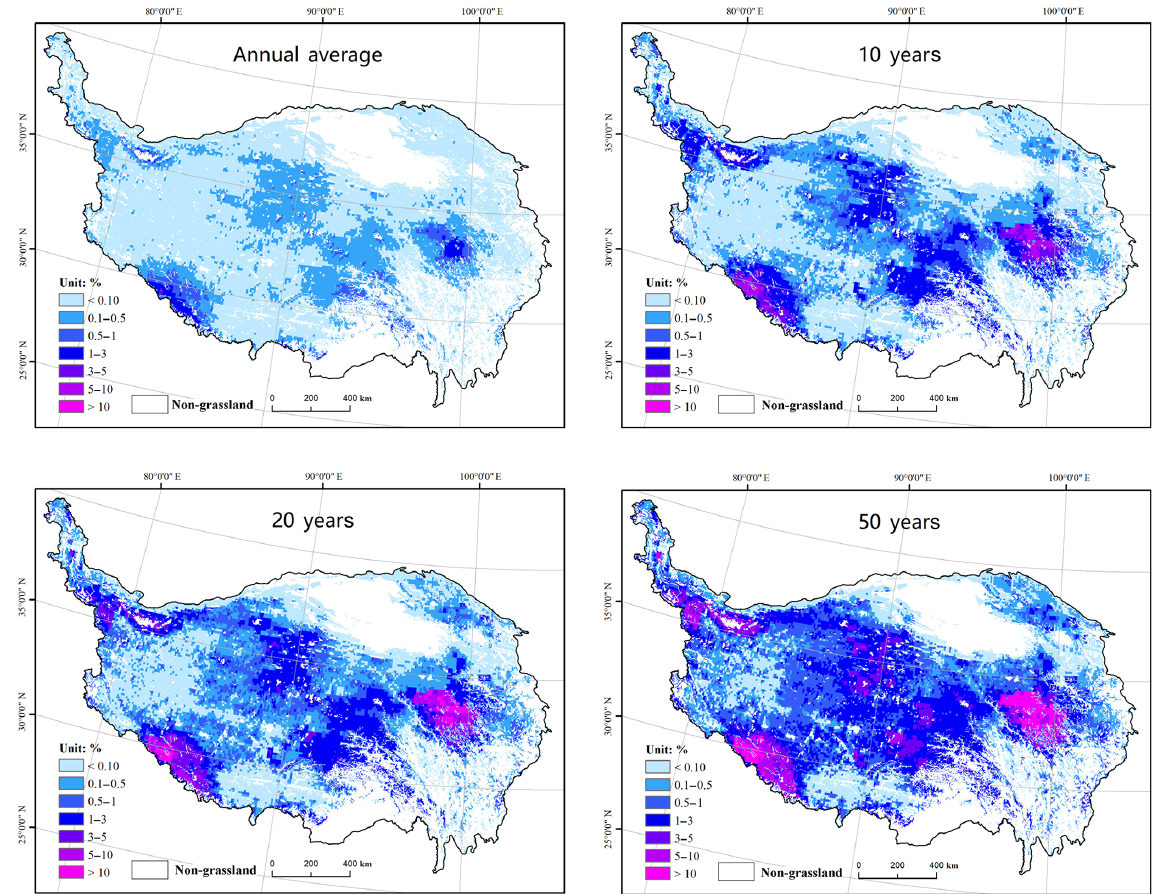
Figure 7. Gridded livestock snow disaster risk in terms of mortality rate (%) in annual-average values, and 10-, 20-, and 50-year return-period values. The grid size is 0.1 ◦ × 0.1 ◦